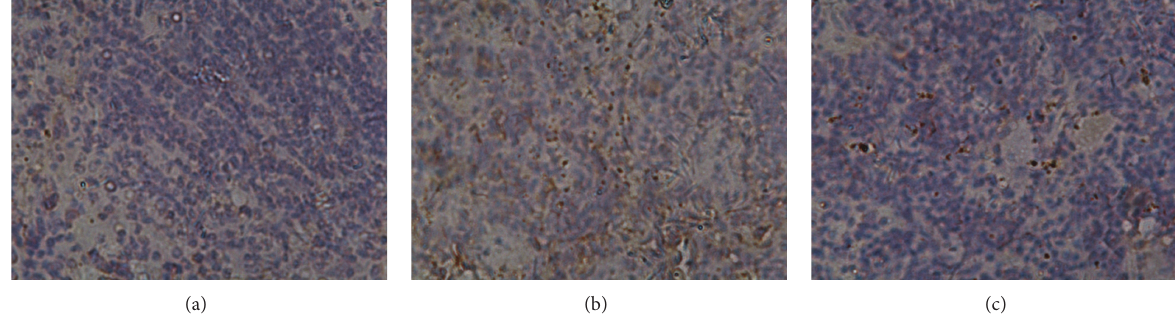
Figure 6: T-bet expression in spleen on d60 in mice with untreated (a), BMF (b), or OCH (c). Mice spleen pathology section was used to measure T-bet expression level in spleen by immunohistochemical staining. The positive cells were defined as tawny granular in cytoplasm and/or